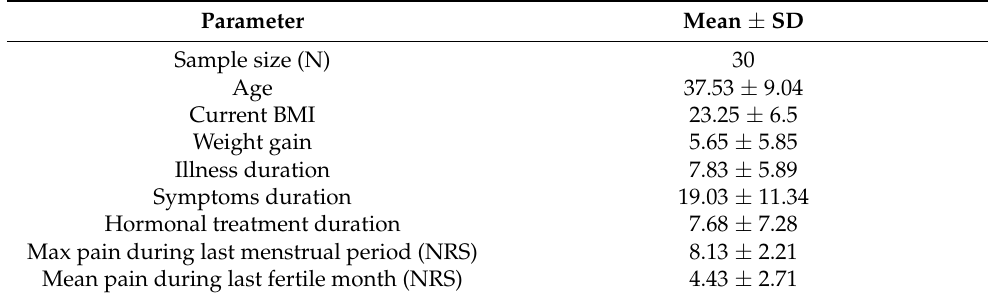
Table 1. Characteristics of the sample.